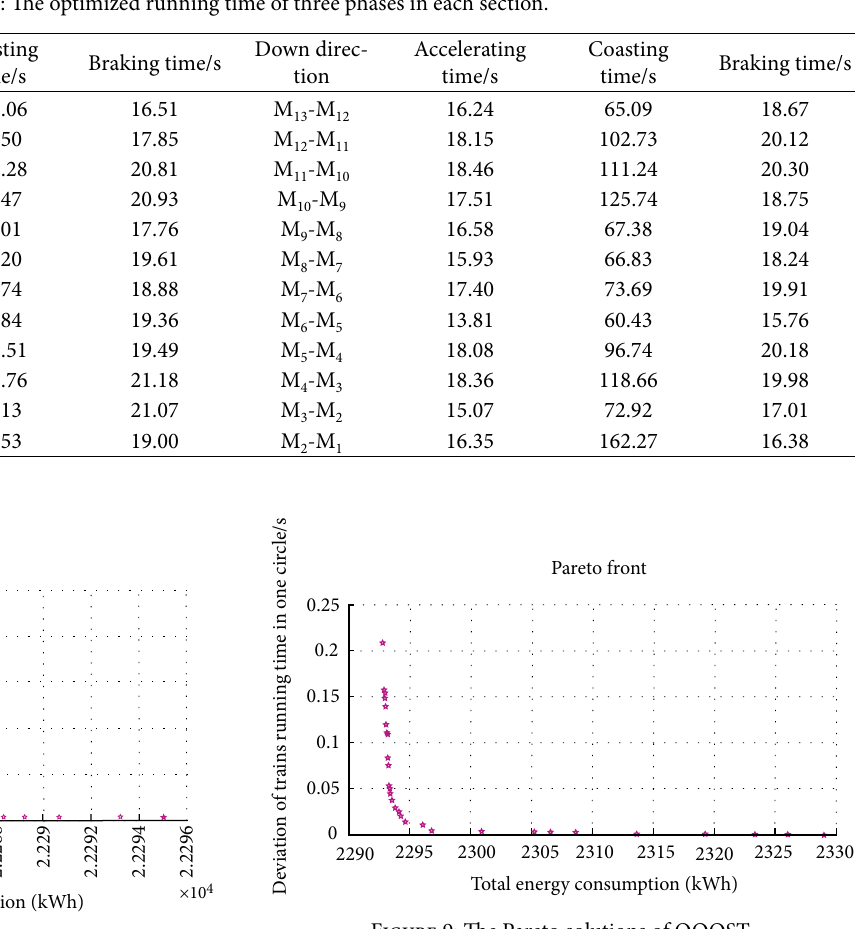
Figure 8: The Pareto solutions of OEST.